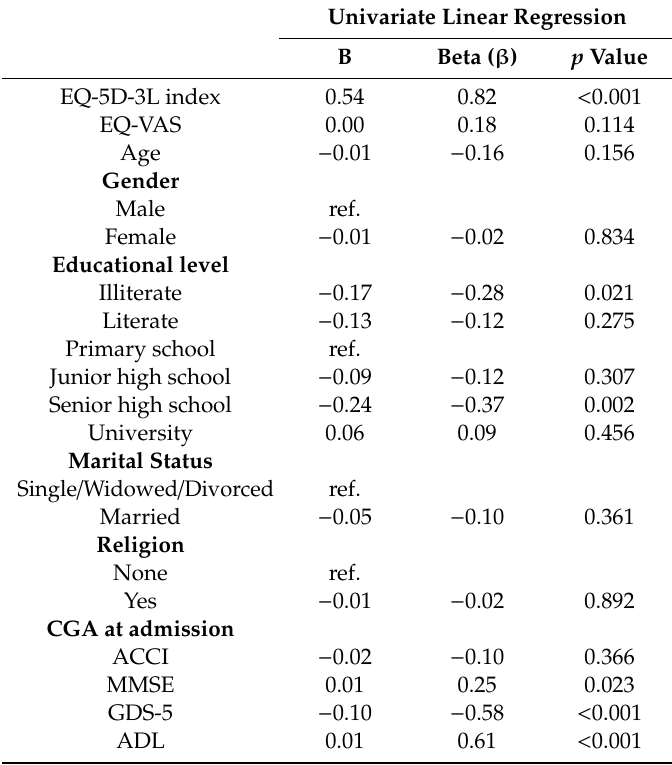
Table 3. Discharge EQ-5D-3L index (Log 10 ) with comprehensive geriatric assessment parameters at